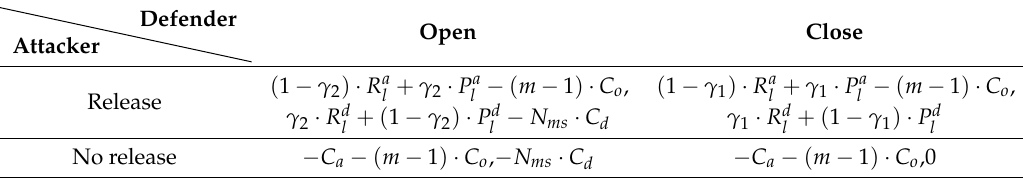
Table 2. Payoff matrix in a time slice with only one defender and one